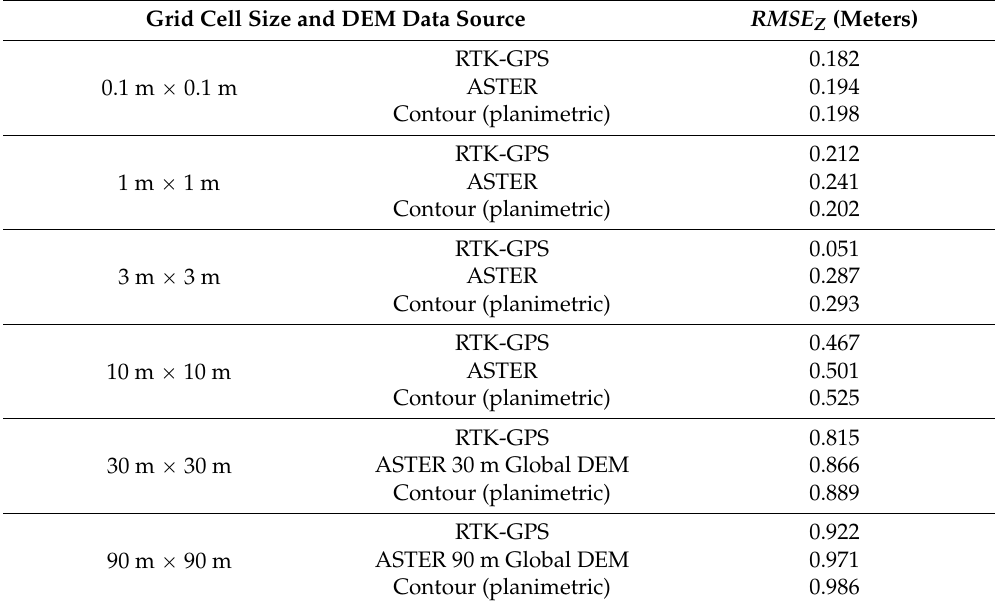
Table 4. Effects of DEM grid size and the accuracy measure in terms of root mean square errors